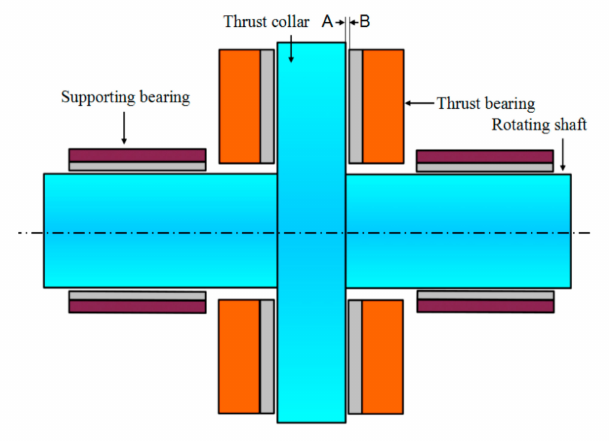
Figure 3. Internal structure of thrust sliding